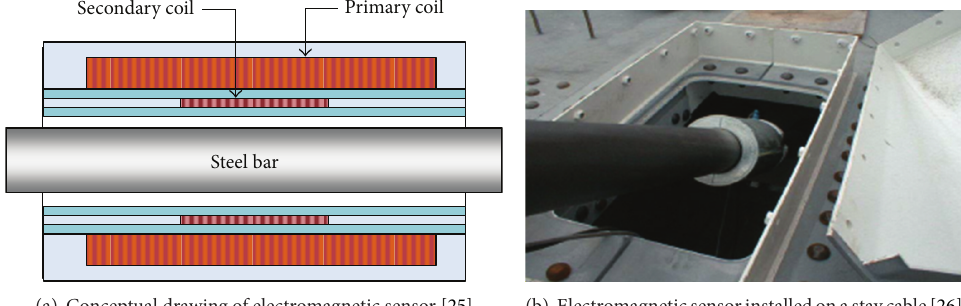
Figure 5: Electromagnetic sensors in bridge cable inspection applications.